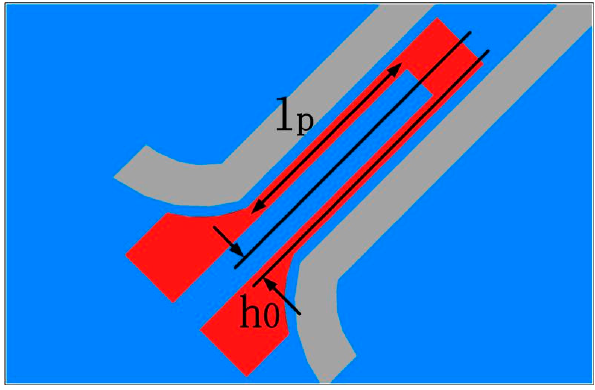
Figure 2. A piezoresistor located at the root of an X- or Y-axis cantilever. Herein h 0 = 1/4 h is designed.